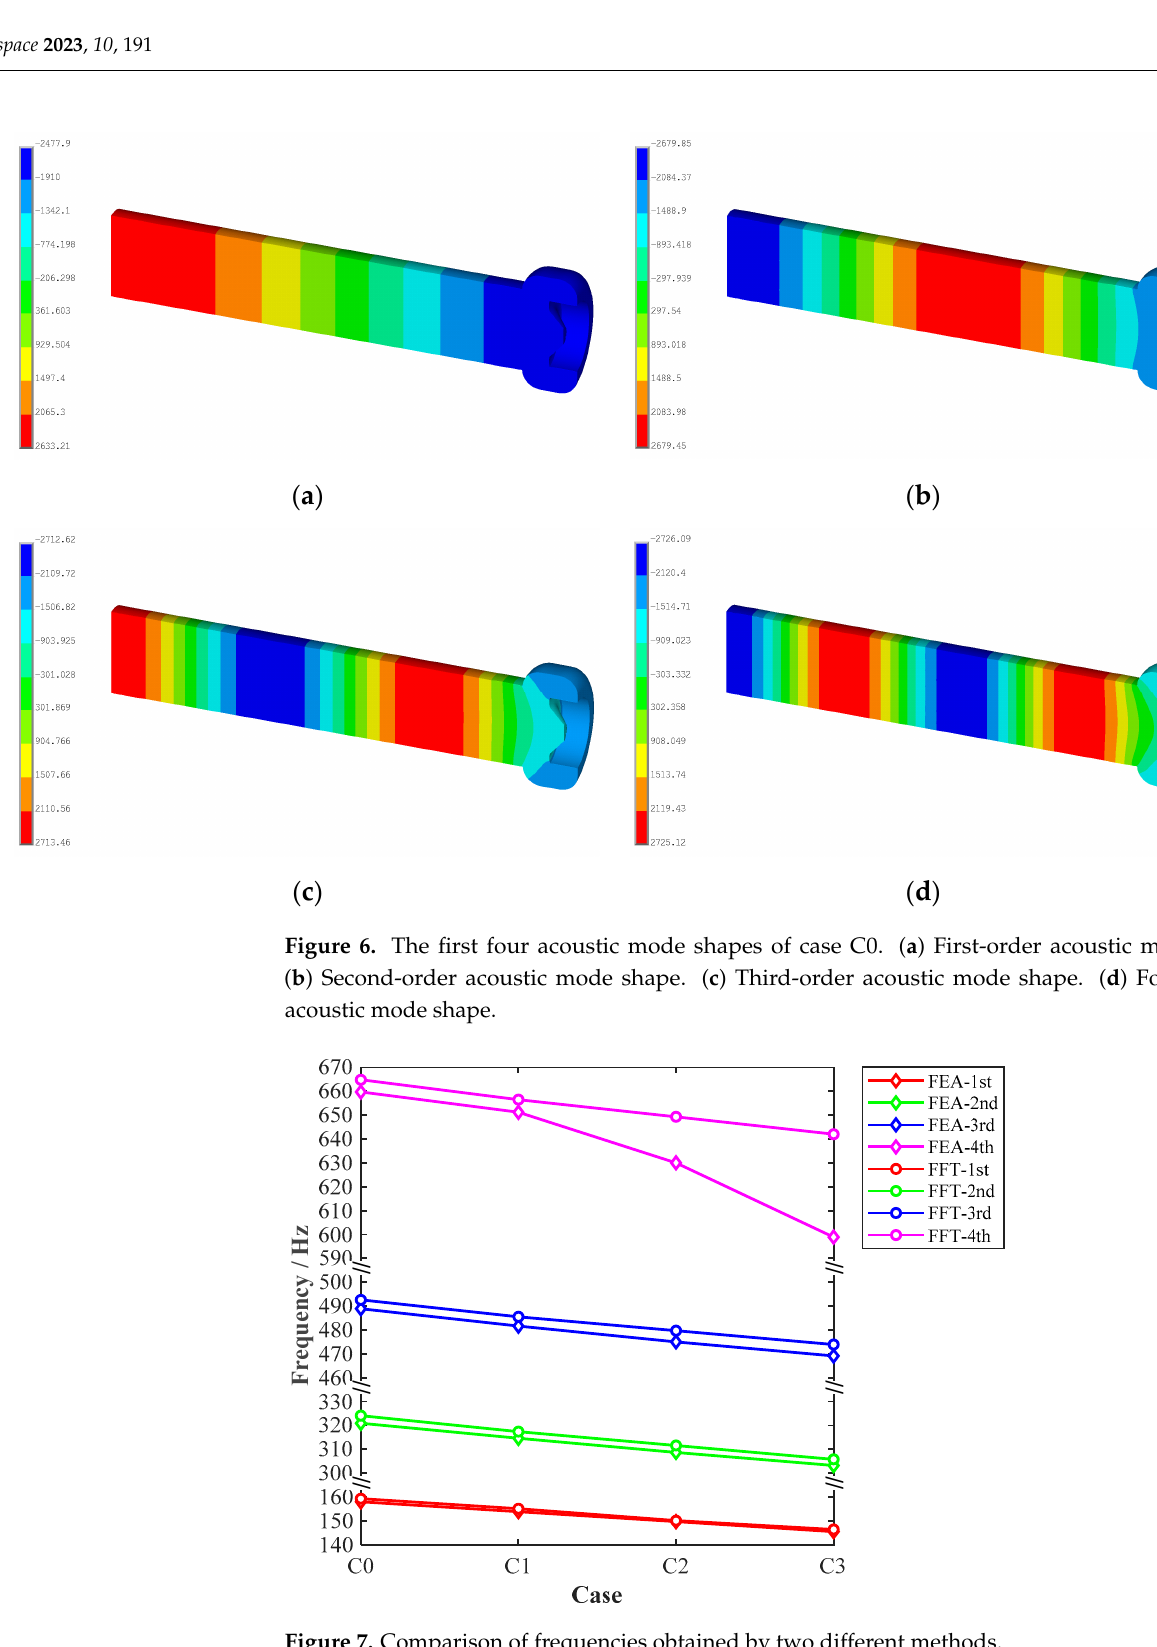
Figure 7. Comparison of frequencies obtained by two different methods.